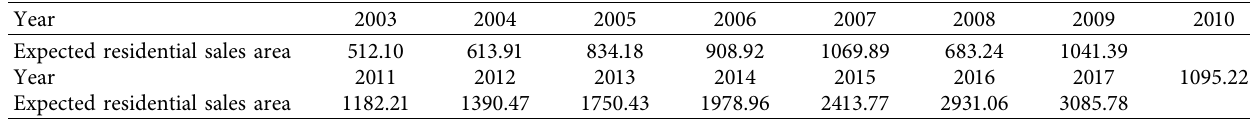
Table 4: Residential sales area in Wuhan over the years.